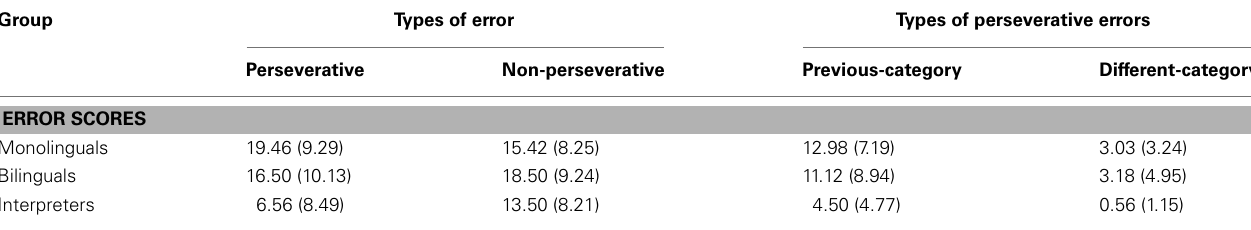
Table 3 | Mean number (and SD) of different types of errors (perseverative and non-perseverative), and mean number (and SD) of types of perseverations (previous-category and different-category perseverations) in each group of